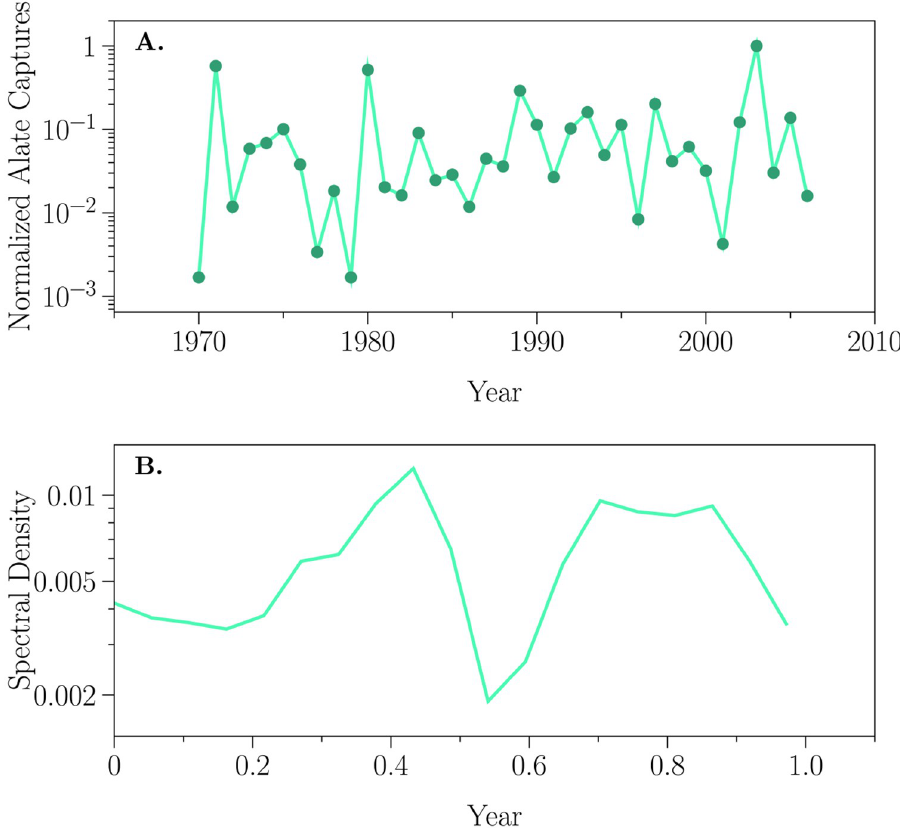
Fig 5. Alate density dynamics. Shown are (A) the time series of alate aphid captures (dots; normalized to the maximum number of captures, see Day et al. [41] for more details) and (B) the associated spectral density function.